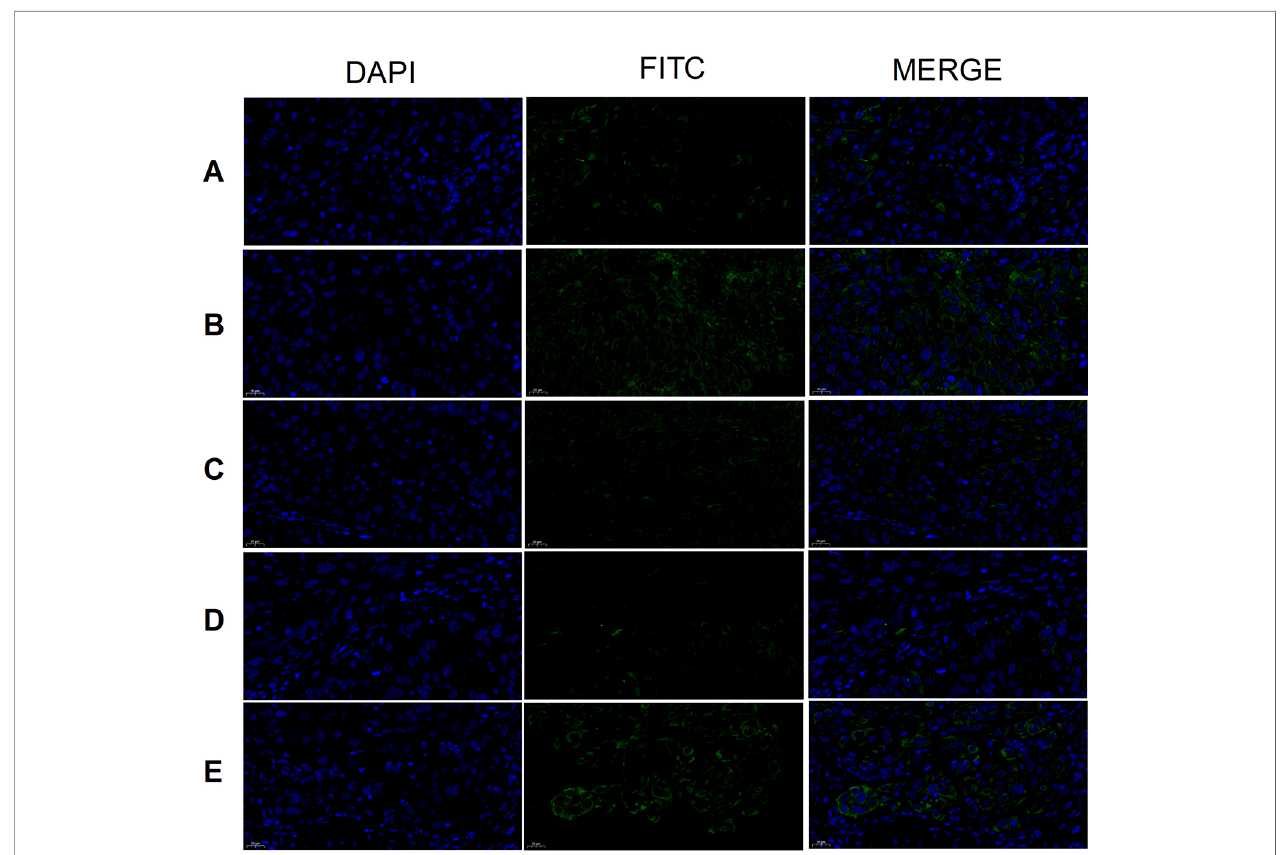
FIGURE 10 | CD133 expression (×400). Model group (A) , cisplatin group (B) , THSWD H group (C) , THSWD M group (D) , THSWD L group (E) .